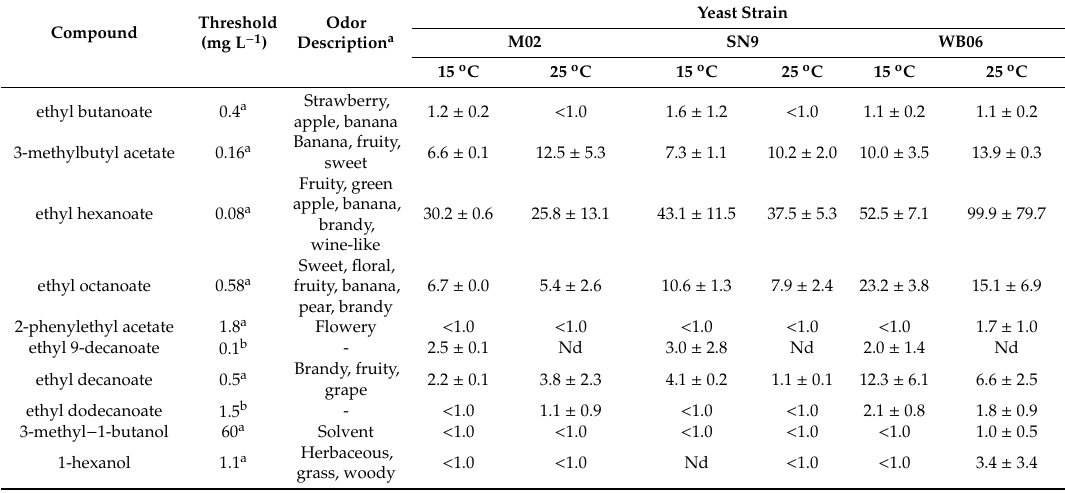
Table 4. Aroma compounds quantified in PABs with odor activity value (OAV) > 1, perception threshold, and aroma